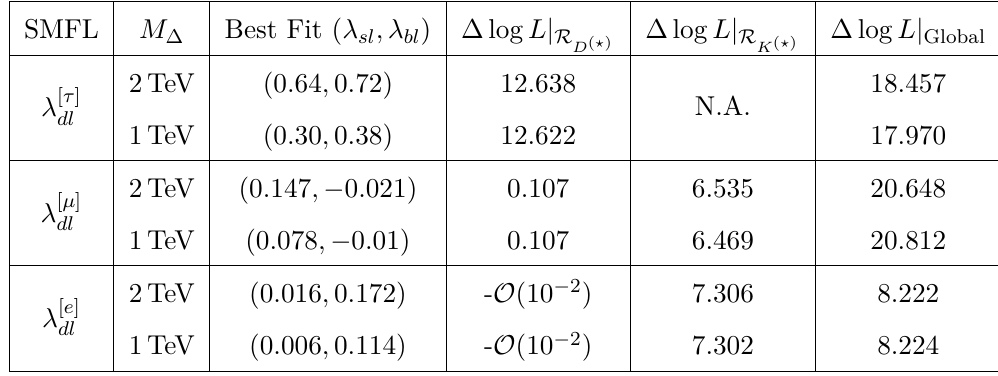
Table 1 . Results from the M ∆ = { 1 , 2 } TeV two-parameter likelihood ( ∆ log L = − ∆ χ 2 / 2 ) scans of section 3.2, including the individual contributions of the (potentially) anomalous observables R . Column 3 gives the best-fit values of ( λ sl , λ bl ) , corresponding to the global likelihood K ( ? ) ,D ( ? ) maximum of the scans, found in column 6, which consider all available data in smelli . Columns 4-5 then give the individual contributions of R to this likelihood (again at the best-fit K ( ? ) ,D ( ? ) coordinates). See the text and figure 2 for more